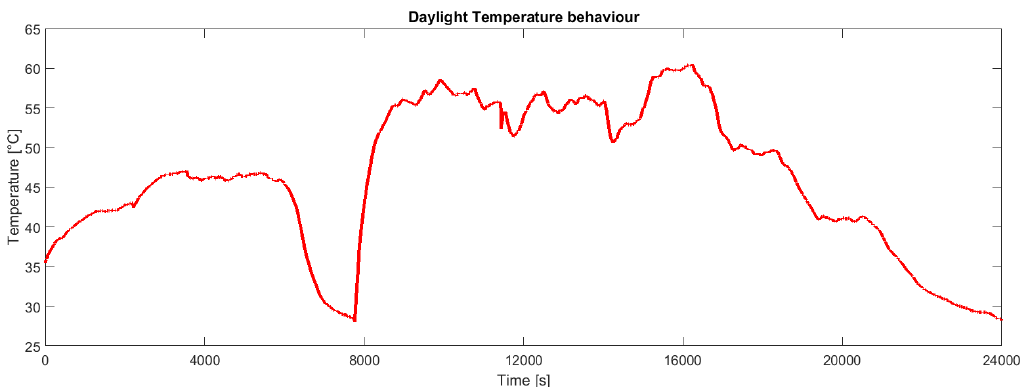
Figure 9. Continuous behavior of the board temperature